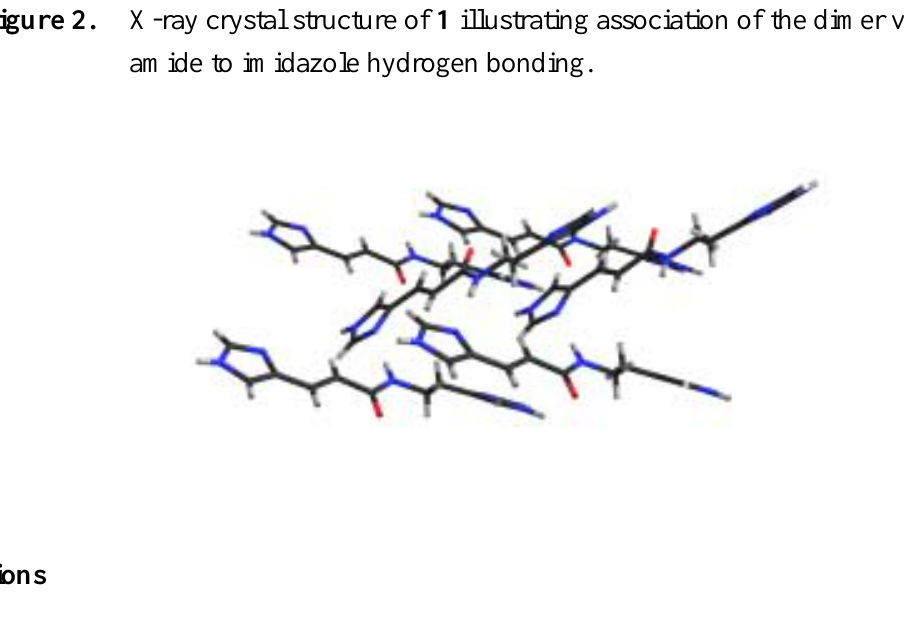
Figure 2. X-ray crystal structure of 1 illustrating association of the dimer via NH…N amide to imidazole hydrogen